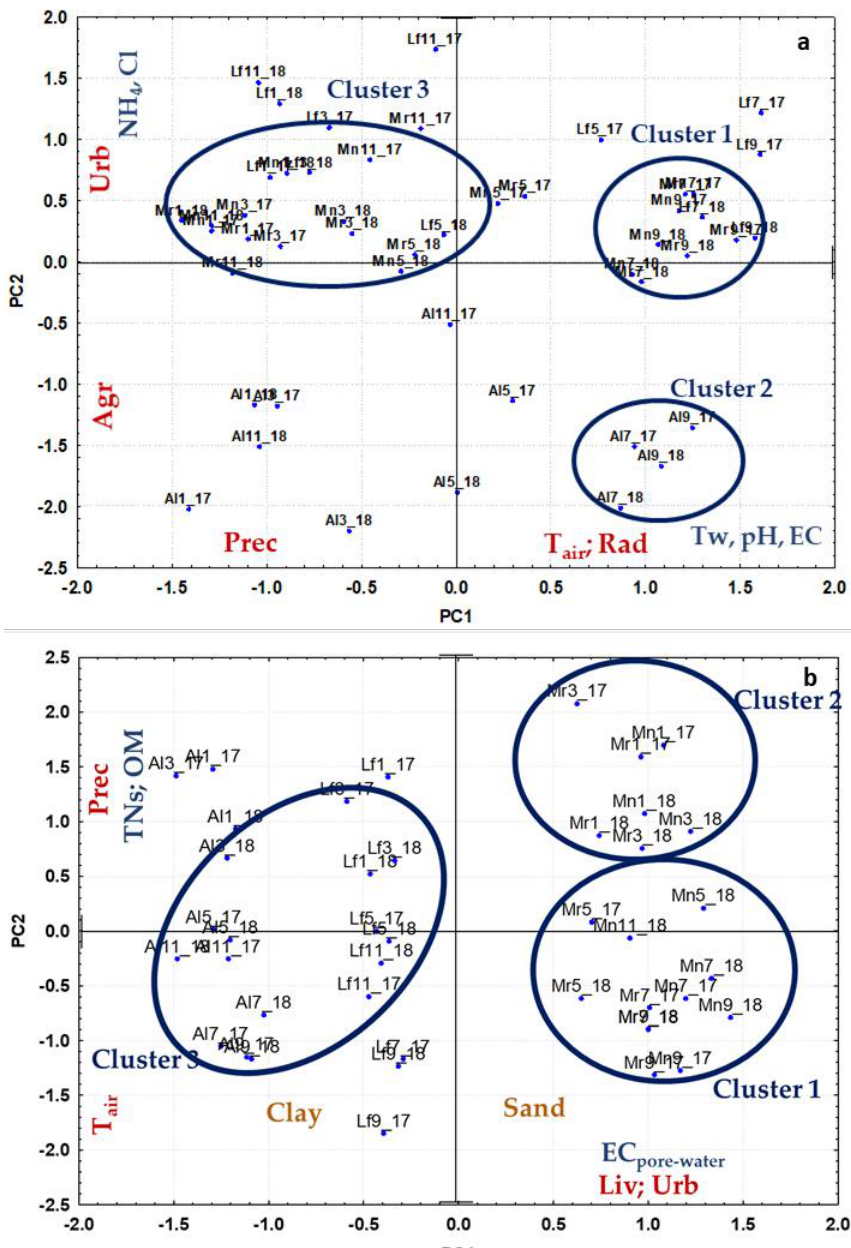
Figure 11. Principal Component Analysis (PCA) plot showing the distribution of the climate factors, Land use/ Land cover (LULC) factors and physicochemical parameters of the Alqueva reservoir water samples ( a ) and sediments samples ( b ) on the bidimensional plane defined by the first two principal components (PC). In the figure are displayed the samples’ scores and the statistically significant clusters obtained through the Square Euclidean distance. Samples were collected at Al, Mn, Mr, Al, Lf, during the years of 2017 and 2018 in the months of January (1); March (3); May (5); July (7); September (9) and November (11).